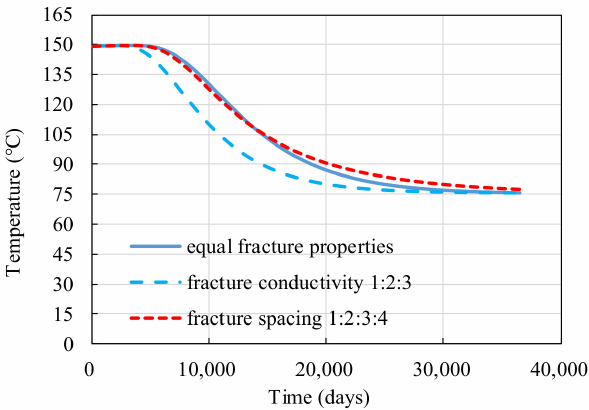
Figure 8. Thermal breakthrough for variable fracture conductivity and spacing.